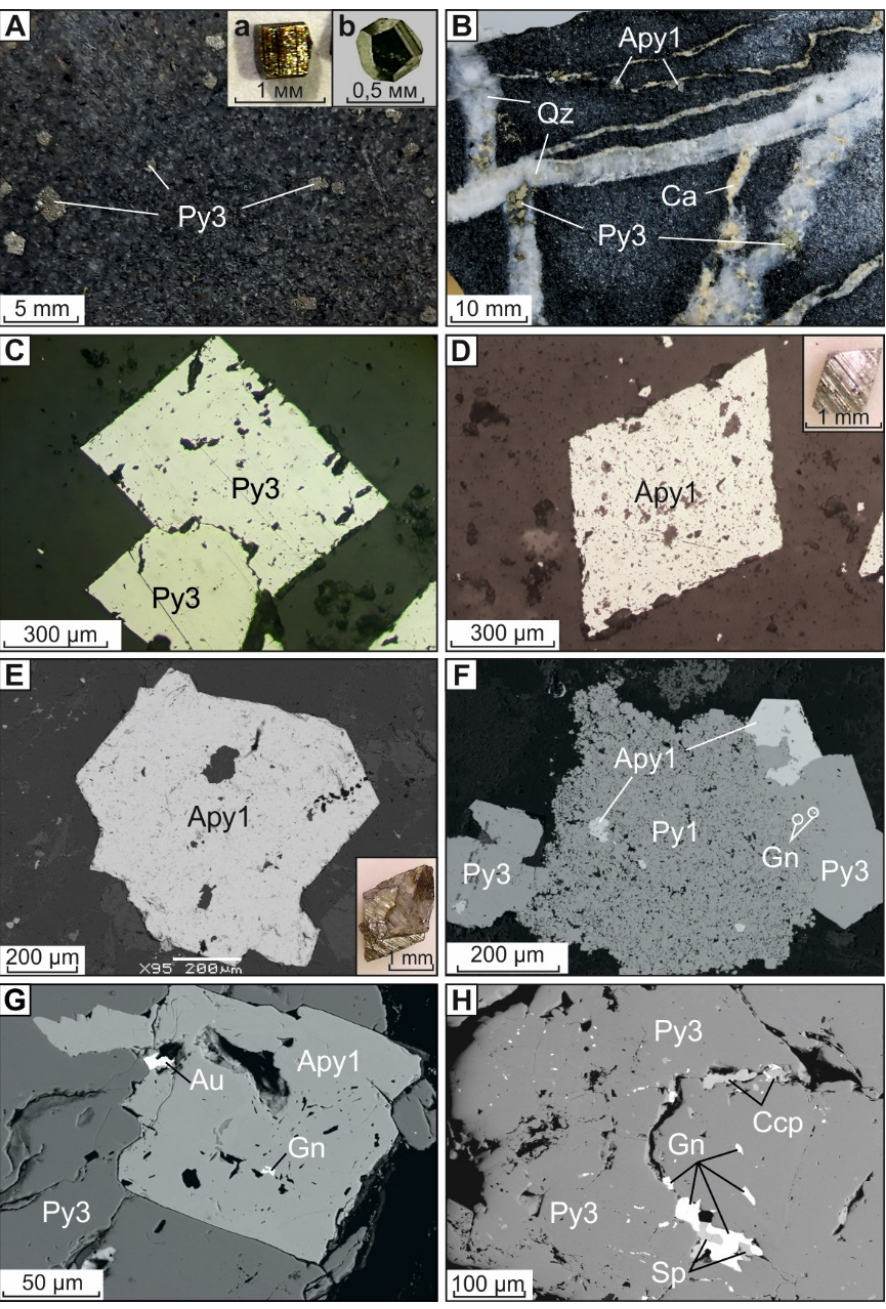
Figure 6. ( A , B ) Photos and ( C,D ) photomicrographs of Py3 and Apy1 of Khangalas deposit in reflected light and ( E – H ) backscattered electrons: ( A ) disseminations of metasomatic Py3 in sandstone; ( B ) vein-disseminated quartz-Py3-Apy1 mineralization; ( C ) Py3 veinlets and bedded-plane Py1 dissemination in siltstone; ( D ) euhedral Apy1; ( E ) Apy1 aggregate; ( F ) intergrowths of Py1, Py3, and Apy1 with galena inclusions (Gn); ( G ) inclusions of native gold (Au) and galena (Gn) in Py3 and Apy1. ( H ) inclusions of sulfides of gold–polysulfide association (Gn, galena; Ccp, chalco- pyrite; Sp, sphalerite) in Py3. Insets: ( A , inset a) cubic Py3; ( A , inset b) pyritohedra Py3; ( D , inset) short prismatic Apy1; ( E , inset) pseudo-pyramidal Apy1.